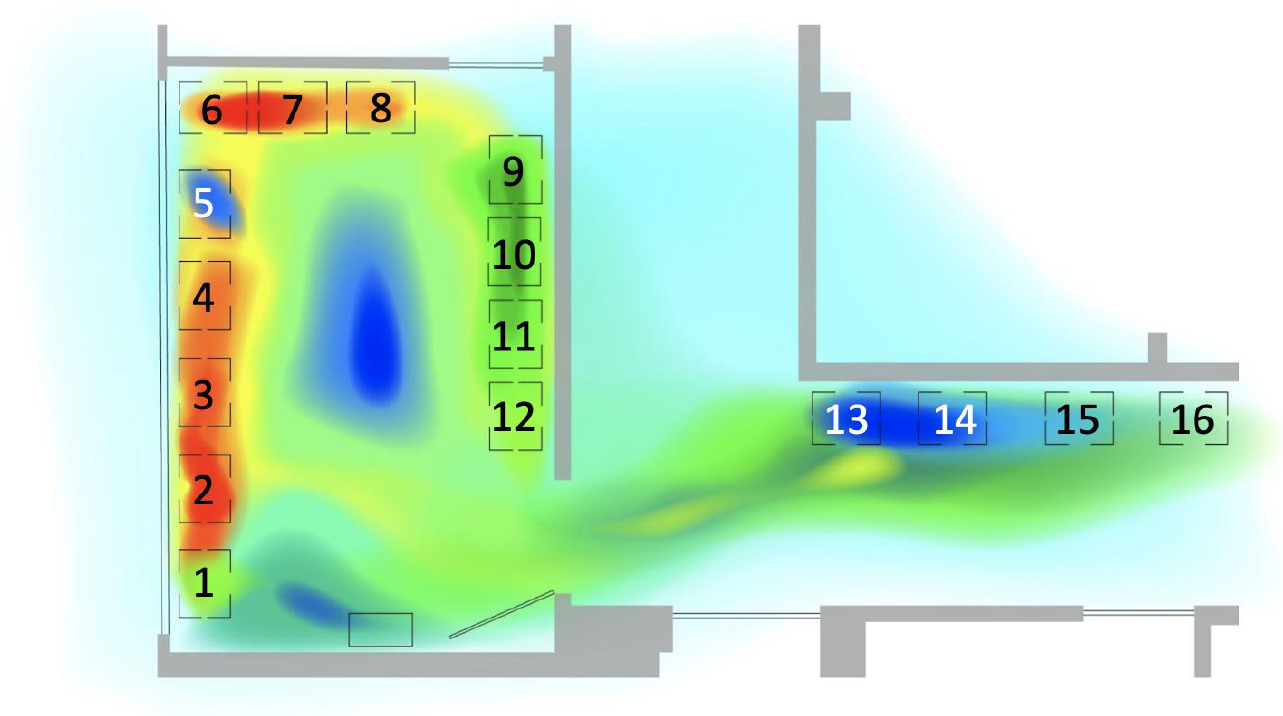
Figure 2. Heat map of locations of people. DOTT recorded people’s locations as frequencies of their X and Y coordinates. These frequencies were used to map ‘hot’ (most frequently occupied, indicated by the warm colors such as red and orange) and ‘cool’ (least frequently occupied, indicated by the cool colors, such as blue and green) spots across the waiting space. The numbers 1–16 refer to chairs 1–16. Table 3. Frequency of Chair Selection organized from highest to